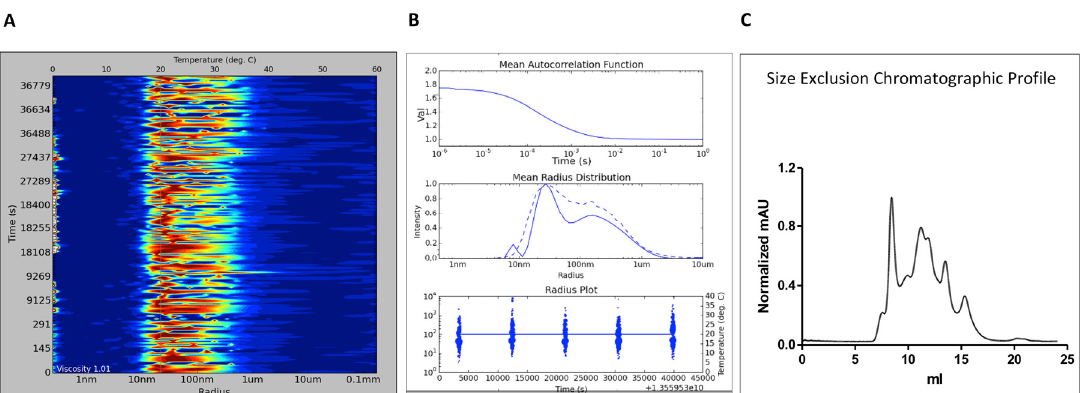
Figure 3. In situ Dynamic Light Scattering (DLS) analysis of A 2A R-BPL nanodiscs. The A 2A R:MSP ratio was 1:80 and the MSP:lipid ratio 1:80. The panel ( A ) shows the size distribution plot in the form of signal heat map while ( B ) shows the DLS in situ analysis through the graphs of the autocorrelation function, radius distribution and radial distribution plot (the blue spot diameter represents the relative scattered light intensity of the detected particles in arbitrary units). Normalised SEC chromatogram is shown in ( C ).